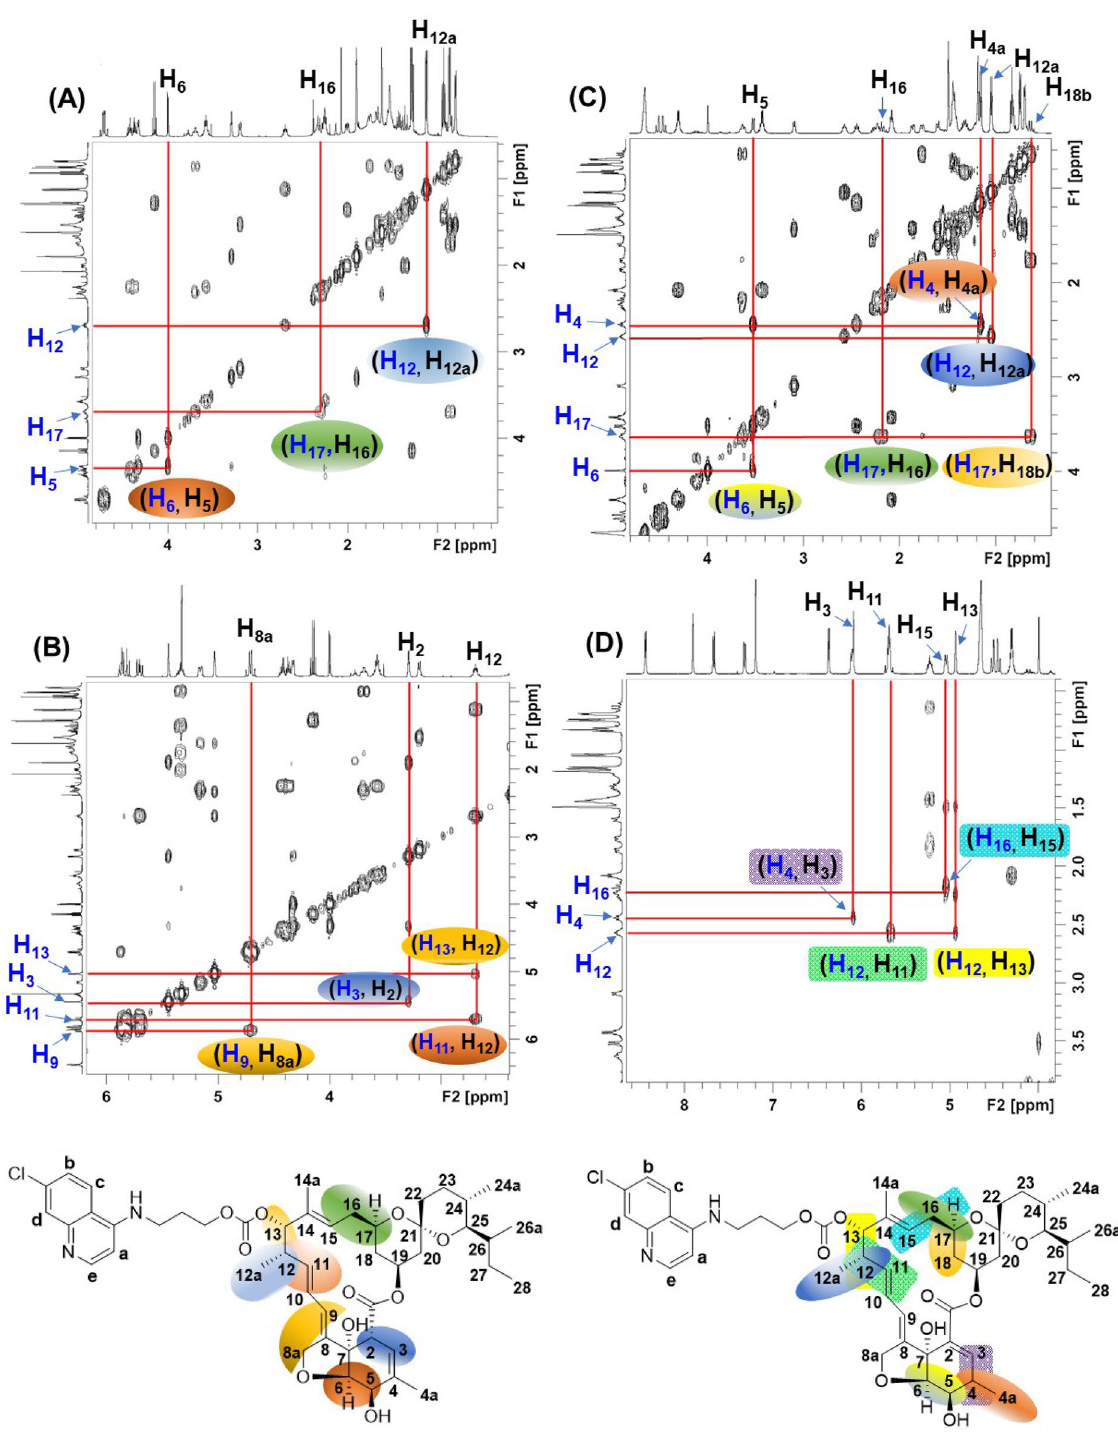
Figure 6. 1 H- 1 H COSY spectrum: ( A , B ): 12a and ( C , D ): 12b